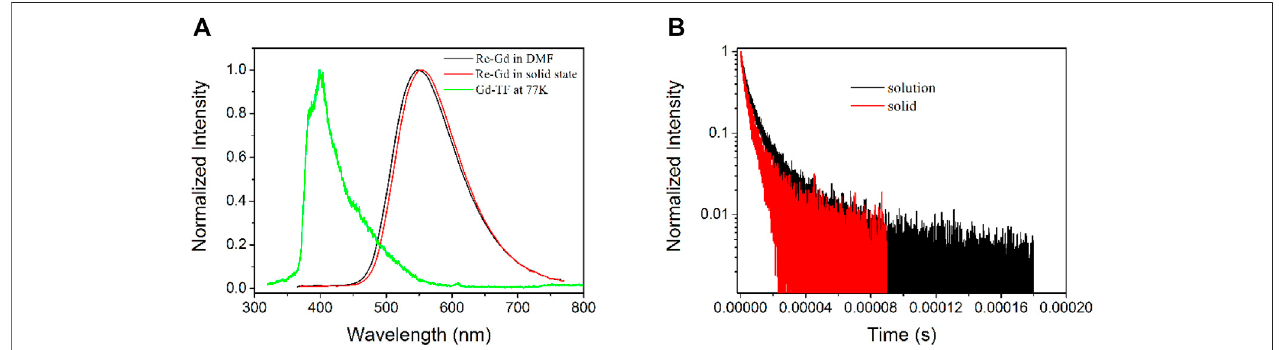
FIGURE 2 | SEM images of Re-Gd@PVP [3 wt%, (A,C) ; 5 wt%, (B,D) ], Re elemental distribution map of Re-Gd@PVP [5 wt%, (E) ] and fl uorescence microscopy image of Re-Gd@PVP [5 wt%, (F) ].